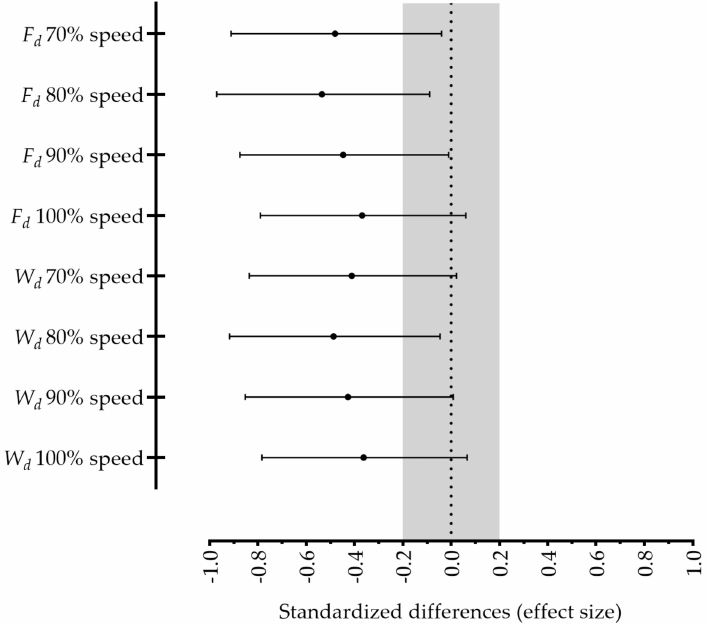
Figure 2. Standardized differences (effect size) between pre- and post-training regarding drag forces ( F d ) and power to overcome drag ( W d ) estimated from the 70%, 80%, 90% and 100% 25 m sprint